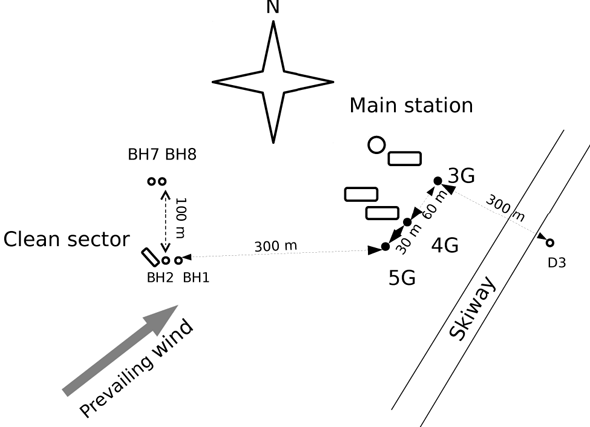
Fig. 2. Map illustrating the location of the camp facilities as well as the different boreholes considered in this study at Vostok